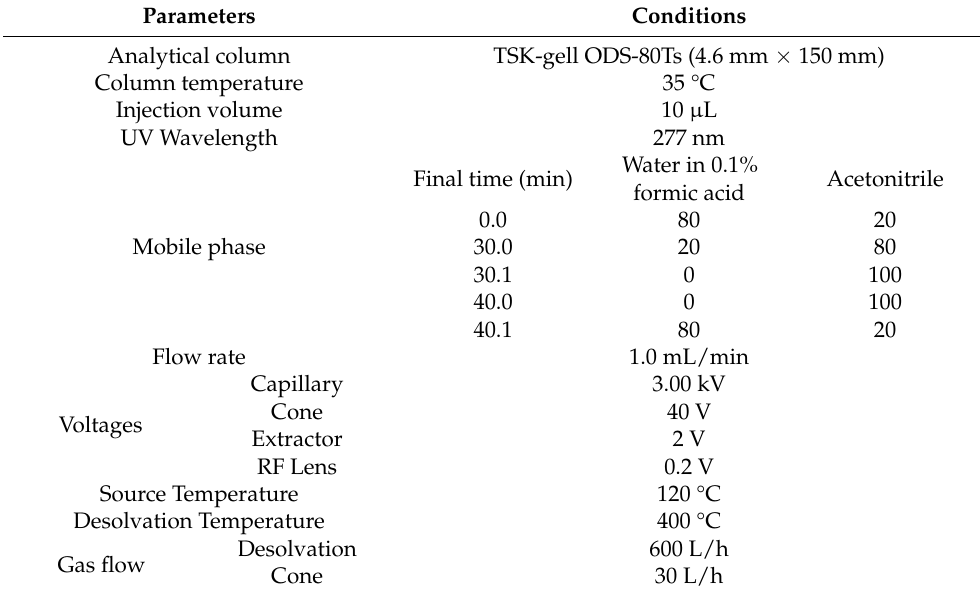
Table 1. The analysis conditions of liquid chromatography–mass spectrometry.